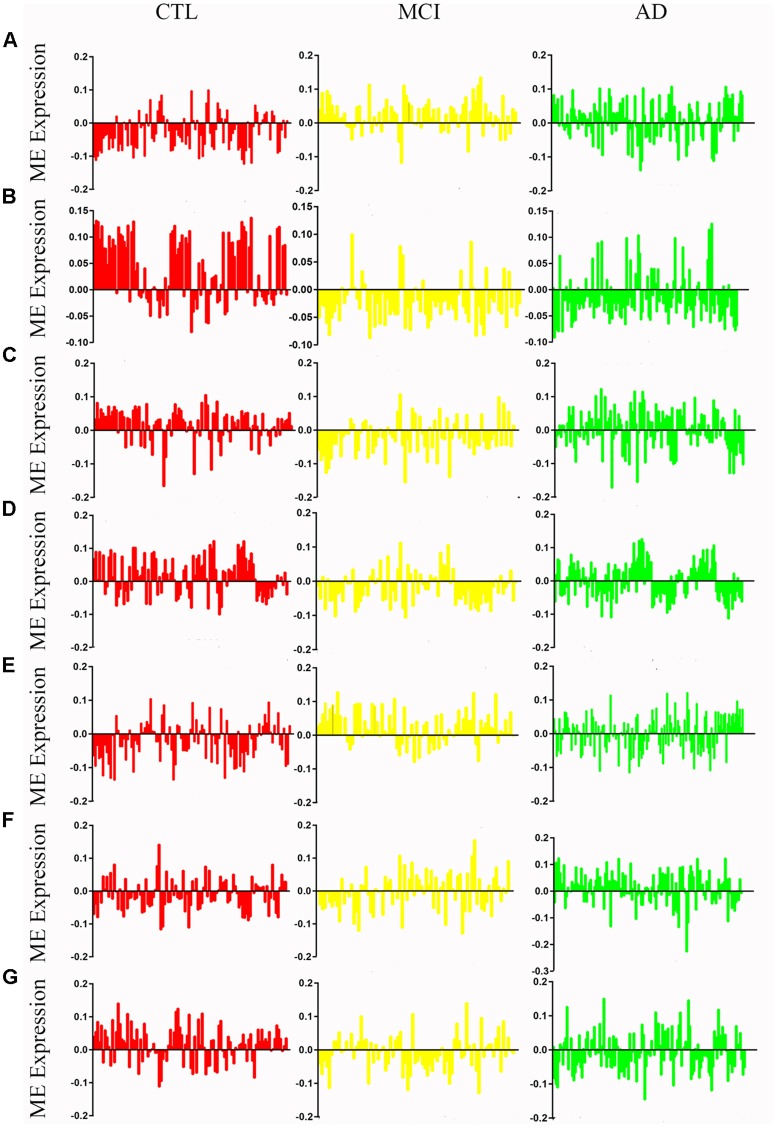
Mean eigengene (ME) expression values across different stages. The samples are grouped in to Control (CTL, red), mild congnitive impairment (MCI, yellow) and Alzheimer’s disease (AD, green). (A) Blue, (B) brown, (C) yellow, (D) turquoise, (E) black, (F) pink, (G) red.